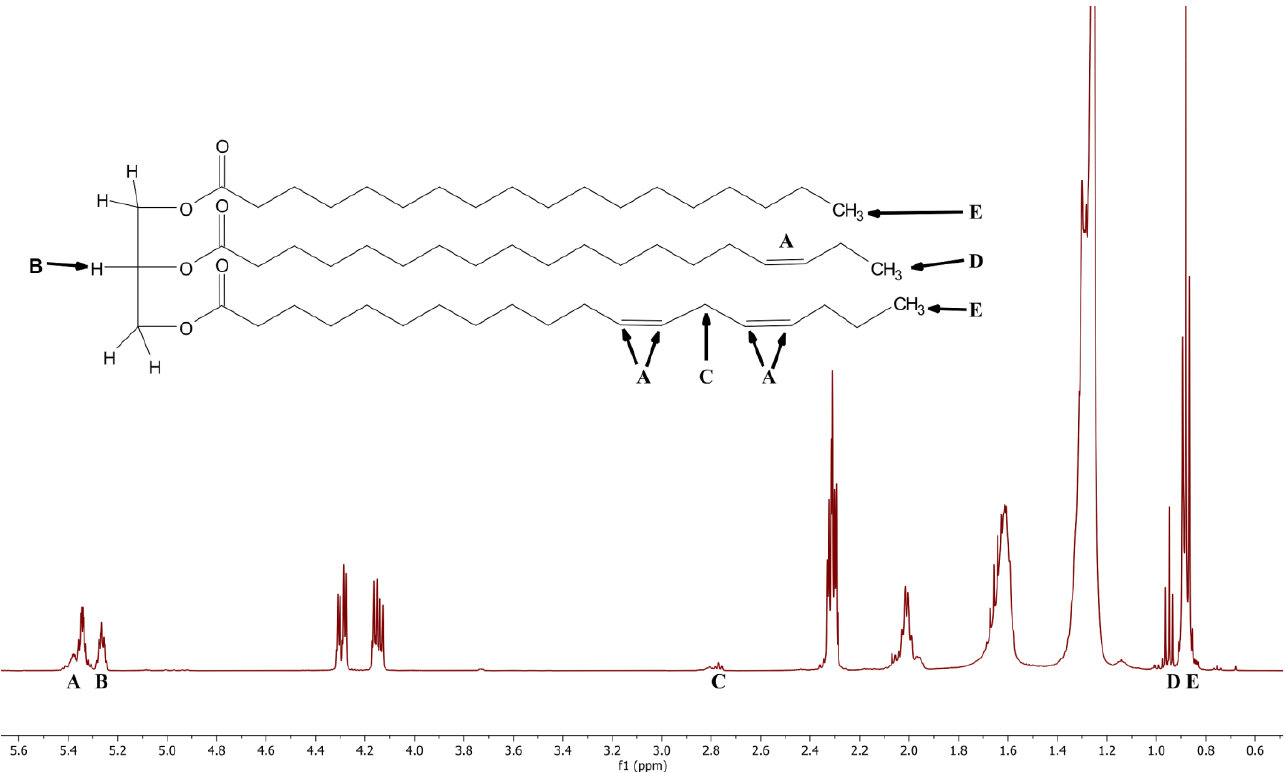
Figure 1. 500 MHz 1 H NMR spectrum of sample B1 (see Table 4 for additional information) with a model triacylglycerol diagram of peaks used for analysis. The A through E labels on the chemical structure correspond to the protons that give rise to the labeled resonances in the NMR spectrum. Table 1. Integrated regions used in this study.